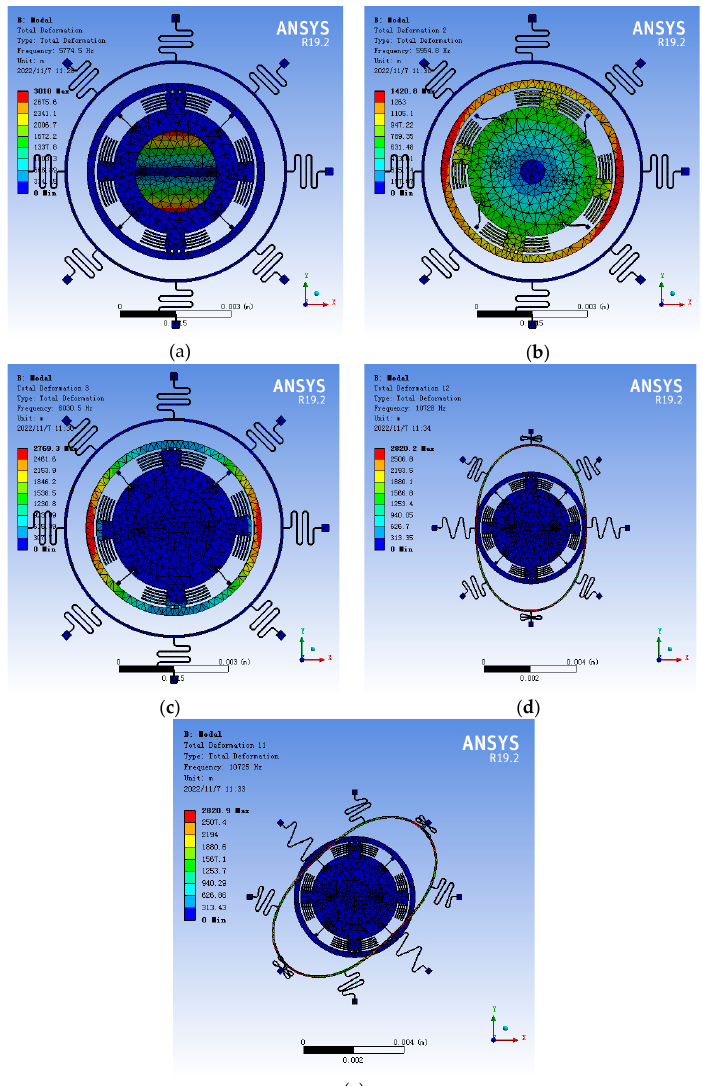
Figure 11. Schematic diagram of the gyroscope operating mode: ( a ) Y-axis sensing mode; ( b ) X/Y-axis driving mode; ( c ) X-axis sensing mode; ( d ) Z-axis driving mode; ( e ) Z-axis sensing mode.